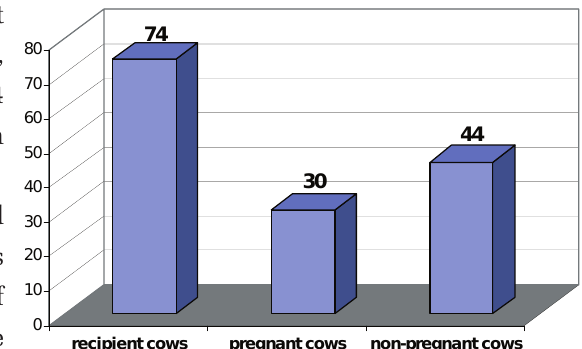
Chart 3. Pregnancy rate obtained in batch